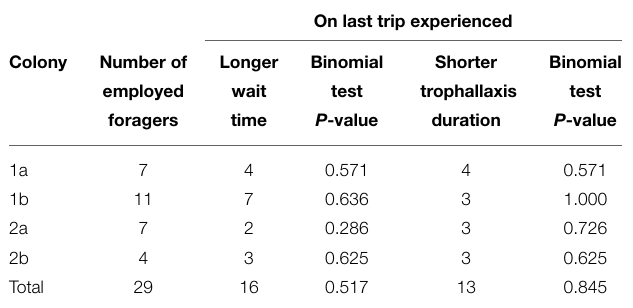
TABLE 1 | The number of “employed” foragers in each experiment, and whether they experienced a longer wait time/shorter trophallaxis duration on the last trip of their employed period compared to the average for previous trips.